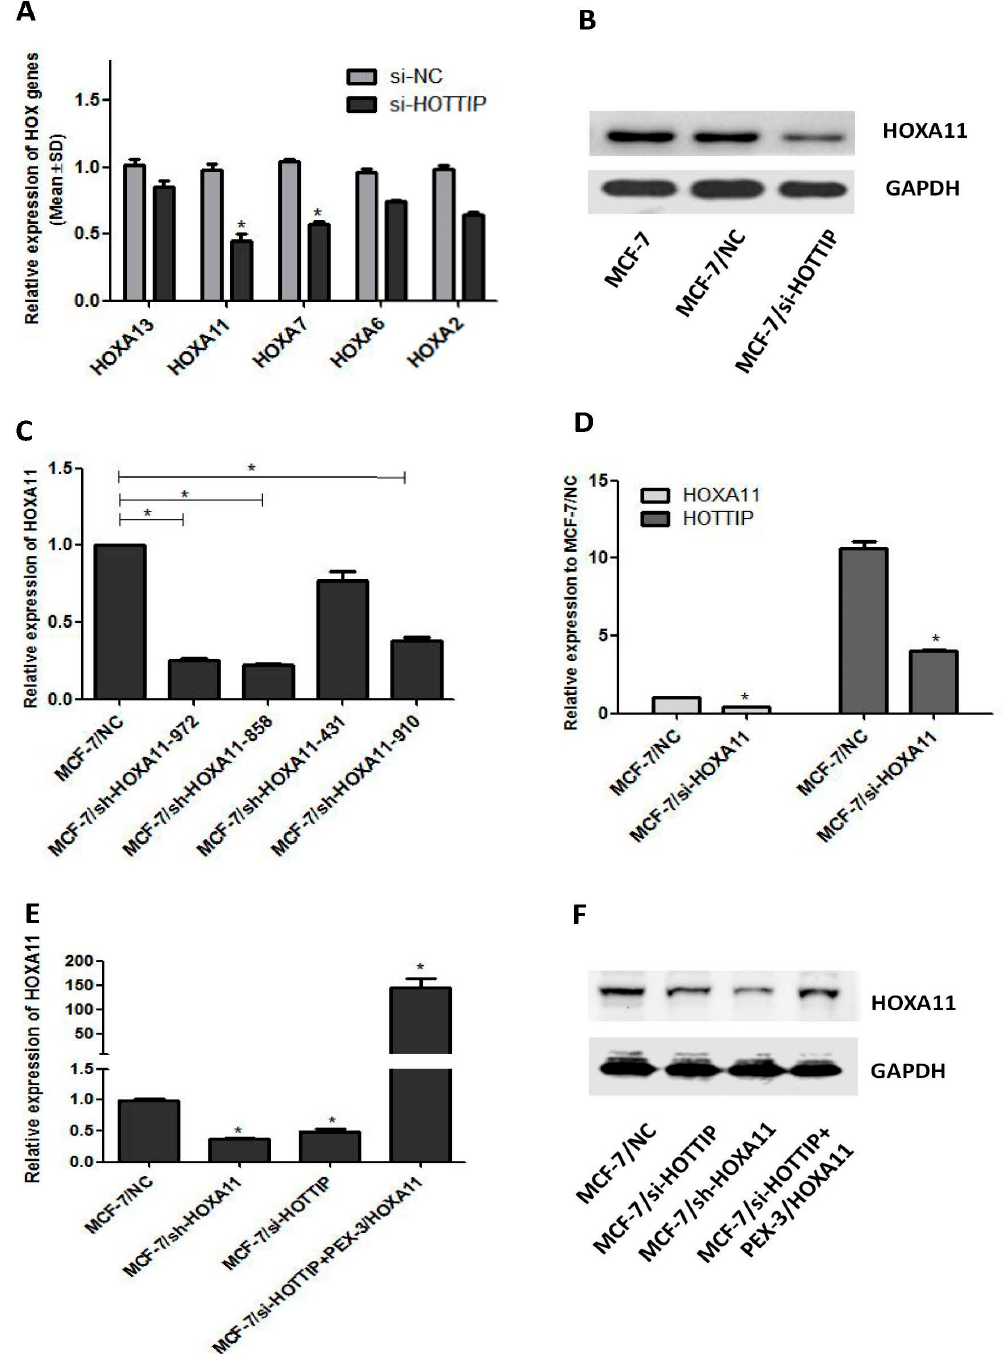
Figure 3. A potential bidirectional regulation loop between HOTTIP/HOXA11 in MCF-7 cells. ( A ): Expression of HOXA genes under HOTTIP knockdown in MCF-7 cells. ( B ): The effect of HOTTIP knockdown on HOXA11 expression at the protein level. ( C ): Screening of HOXA11 shRNA sequences by RT-qPCR. ( D ): HOXA11 knockdown decreased the expression of HOTTIP by RT-qPCR. ( E ): Rescue experiment of HOXA11 downregulation by HOTTIP knockdown by RT-qPCR. ( F ): Rescue experiment of HOXA11 downregulation by HOTTIP knockdown by Western blot. * p < 0.05.